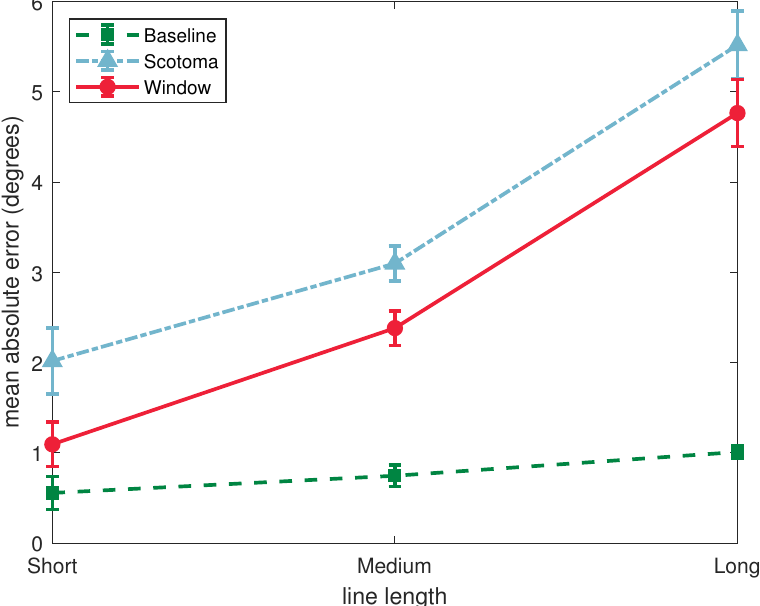
Figure 4. Results show absolute deviation from midpoint, where all responses report an underesti- mation (on